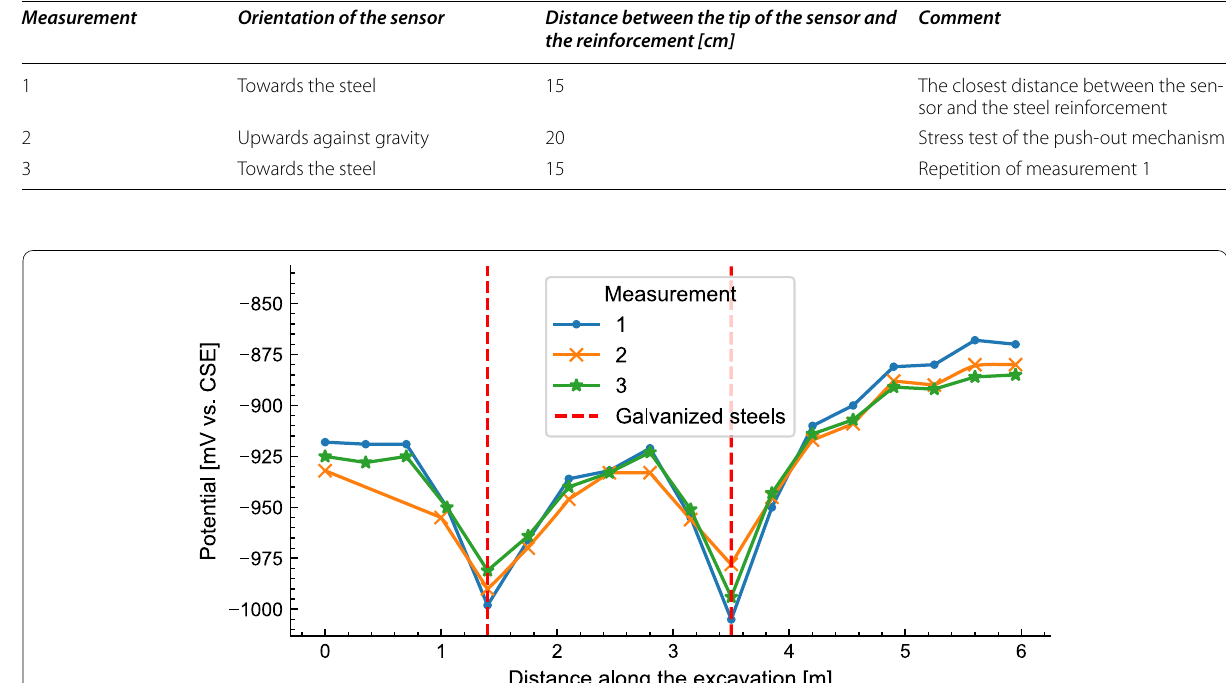
Fig. 15 Result of the HCP mapping with different distances towards the steels with the prototype with the marked locations of the galvanised steels acting as anodes in the electrochemical system during the field